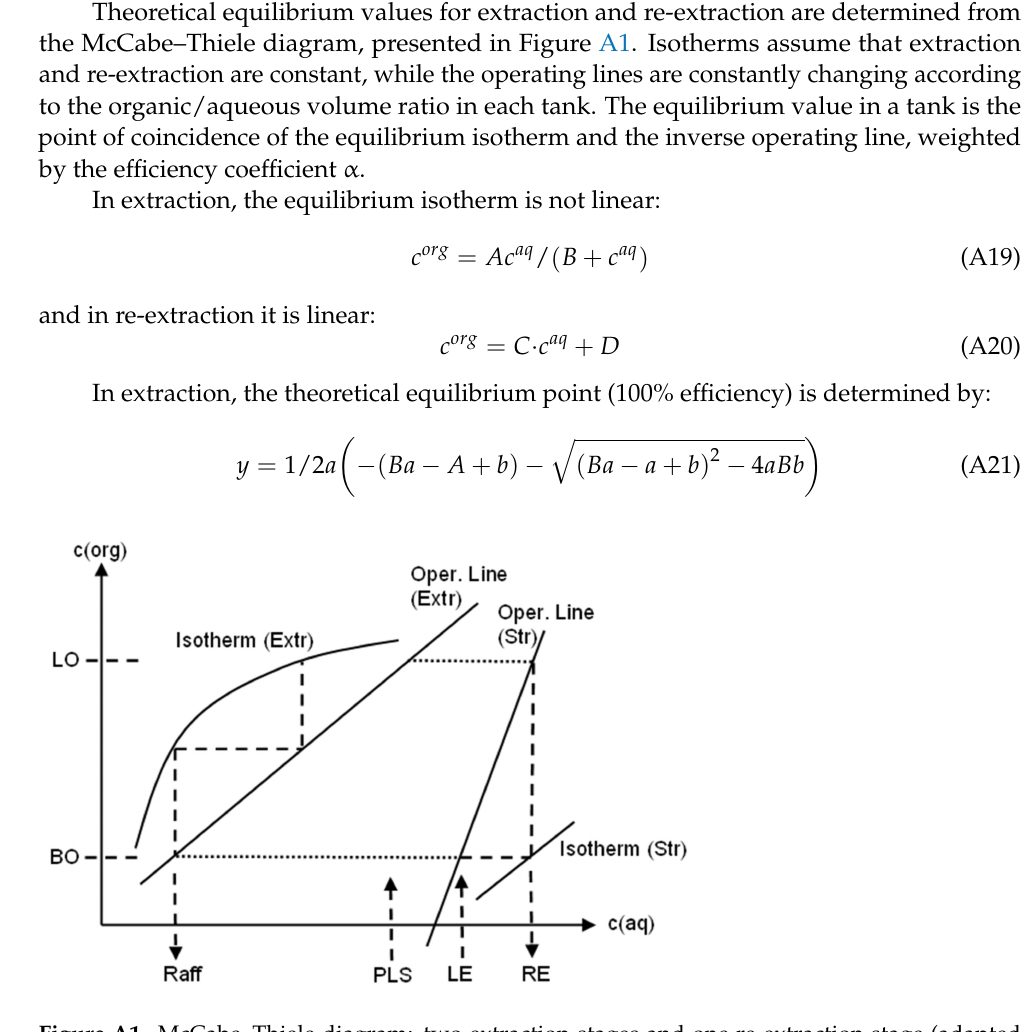
Figure A1. McCabe–Thiele diagram: two extraction stages and one re-extraction stage (adapted from